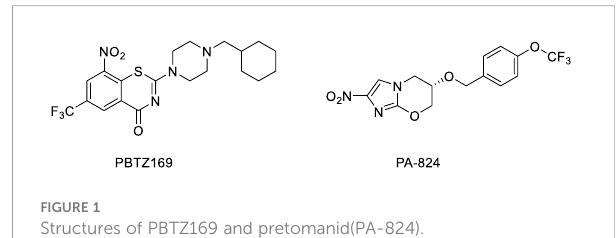
FIGURE 1 Structures of PBTZ169 and